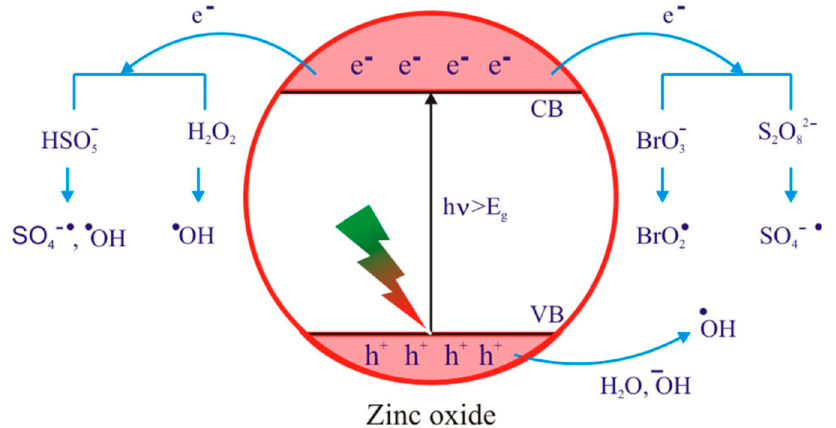
Figure 25. Generation of free radicals with different oxidizing agents in ZnO suspension. Reprinted by permission from Springer Nature: Chemical papers [35] Copyright, 2017.